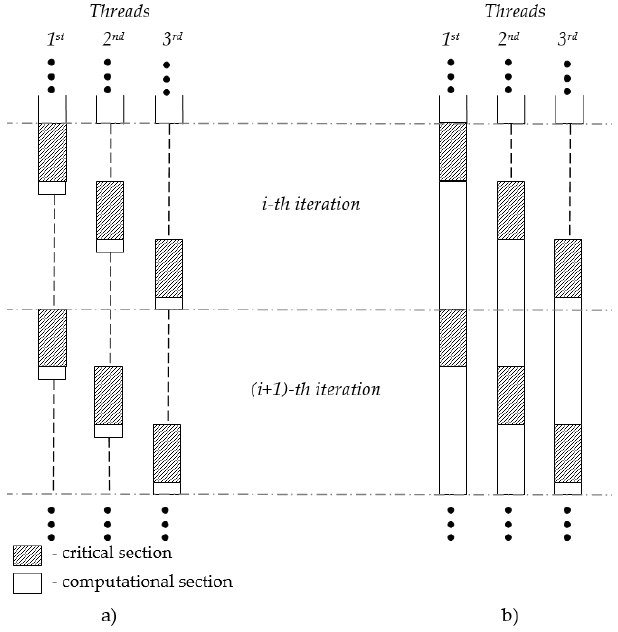
Figure 2. Example of situations for ( a ) worst-case waiting time and ( b ) best-case waiting